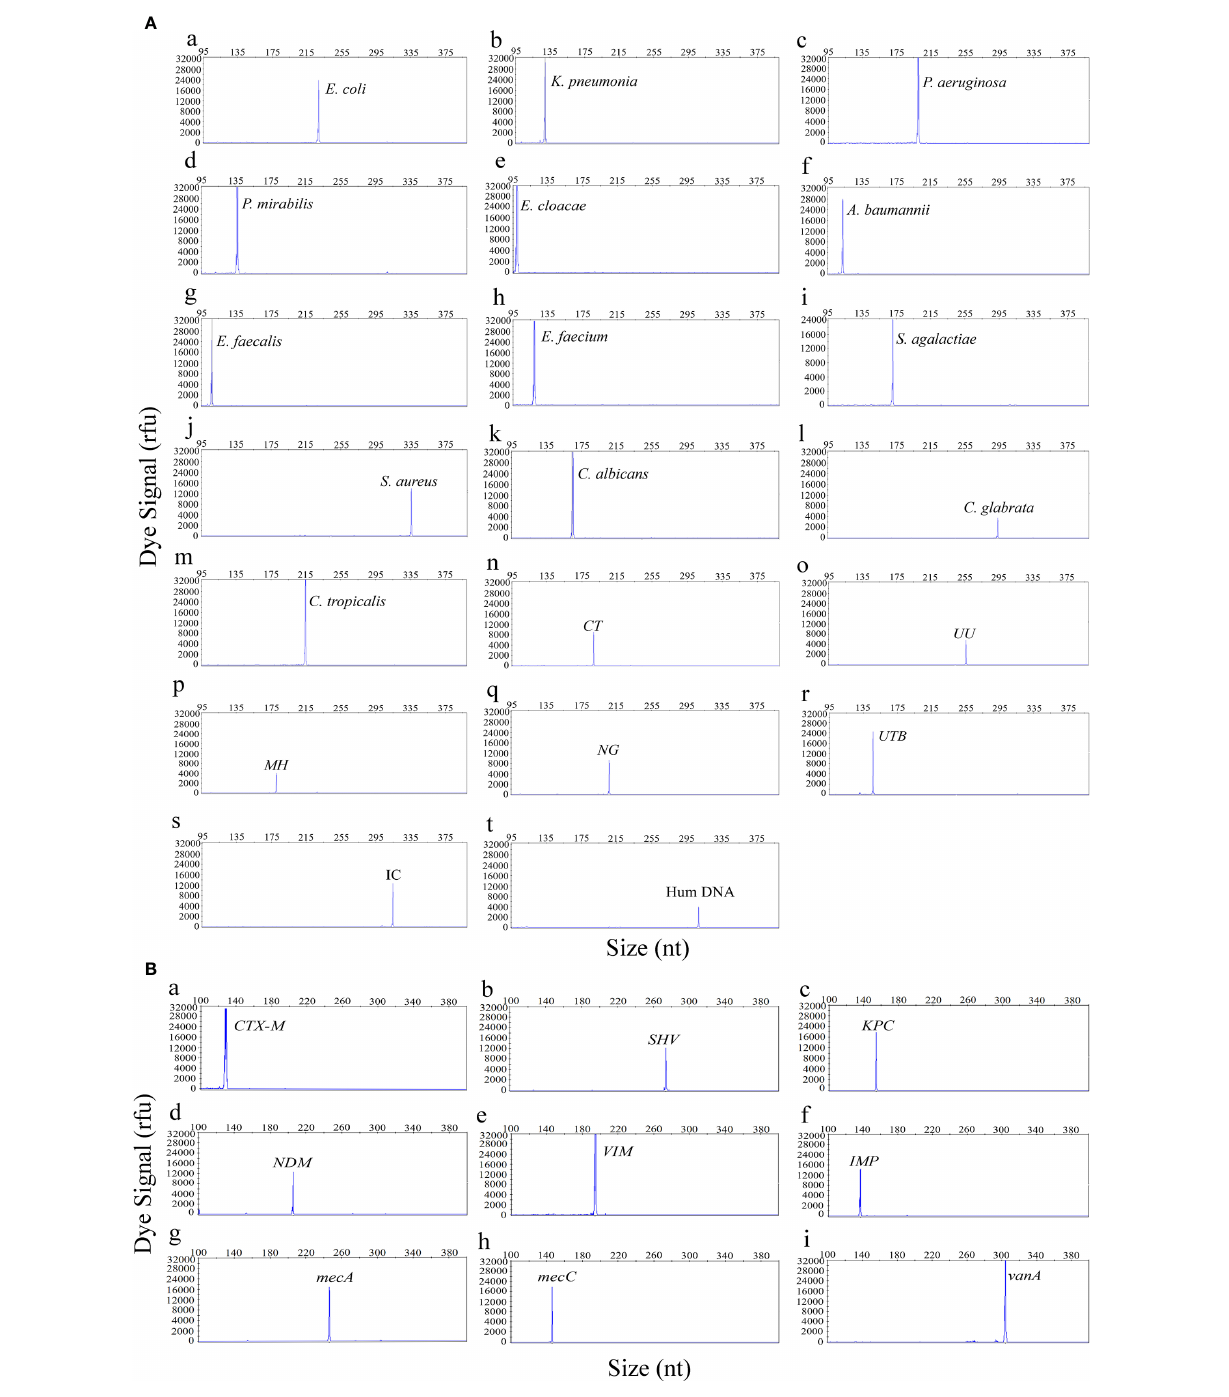
FIGURE 1 | The UTI-HMGS assay produced speci fi c ampli fi cation signals for all 29 targets in the panel of uropathogens (A) and the panel of resistance genes (B) . The X-axis indicates the actual PCR product size while the Y-axis indicates the dye signal. A (a-t) Shows results arising from the ampli fi cation of 18 uropathogens and two control genes: E. coli , K. pneumoniae , P. aeruginosa, P. mirabilis , E. cloacae , A. baumannii , E. faecalis , E. faecium , S. agalactiae , S. aureus , C. albicans , C. glabrata , C. tropicalis , CT, UU, MH, NG, UTB, IC and Hum DNA respectively. B (a-i) Shows results arising from the ampli fi cation of nine resistance genes: bla CTX-M , SHV , bla KPC , bla NDM , bla VIM , bla IMP , mecA , mecC and vanA , respectively. Note that all gene targets were speci fi cally ampli fi ed without non-speci fi c ampli fi cation by